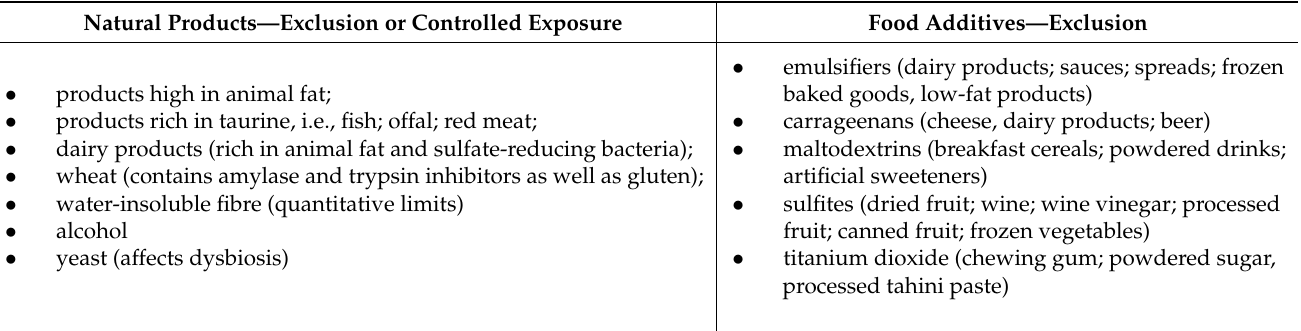
Table 1. Major food groups eliminated in the Crohn’s Disease Exclusion